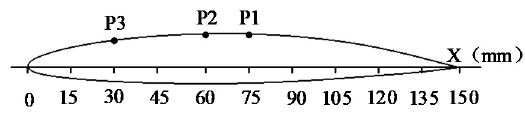
Figure 3. Locations of monitoring points.